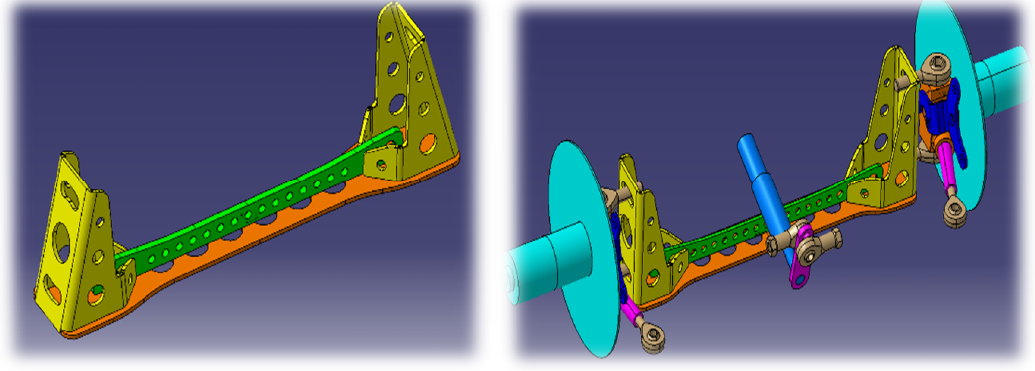
Figure 29. Front axle no. 1 in SolidWorks environment.